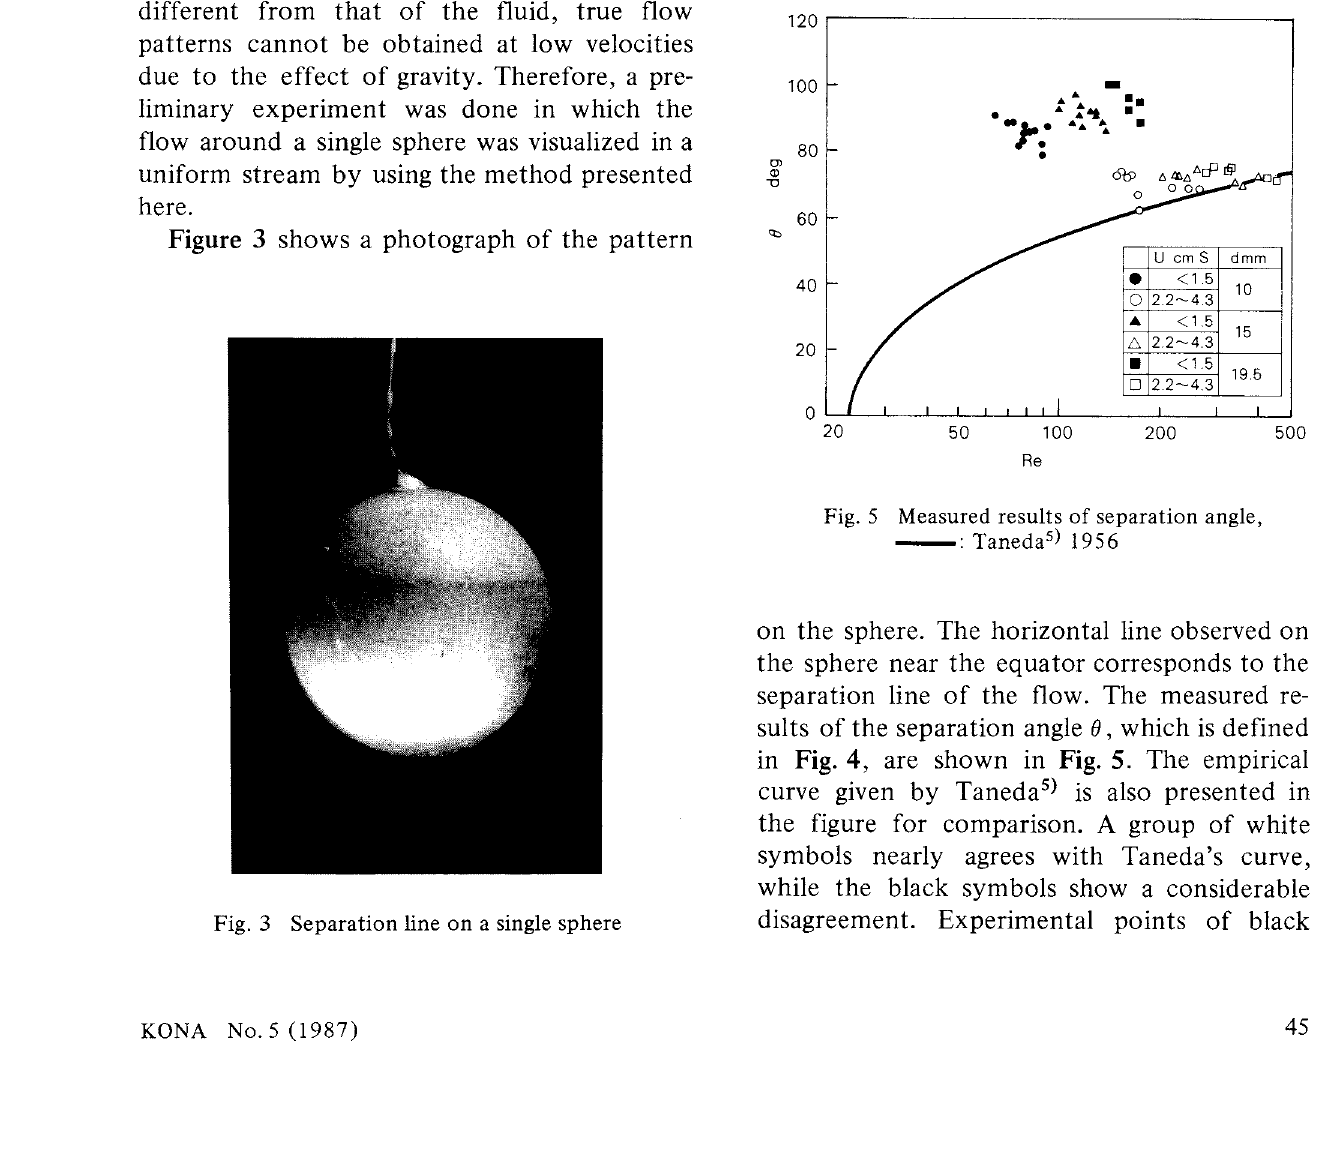
on the sphere. The horizontal line observed on the sphere near the equator corresponds to the separation line of the flow. The measured re sults of the separation angle e, which is defined in Fig. 4, are shown in Fig. 5. The empirical curve given by Taneda 5 l is also presented in the figure for comparison. A group of white symbols nearly agrees with Taneda's curve, while the black symbols show a considerable disagreement. Experimental points of